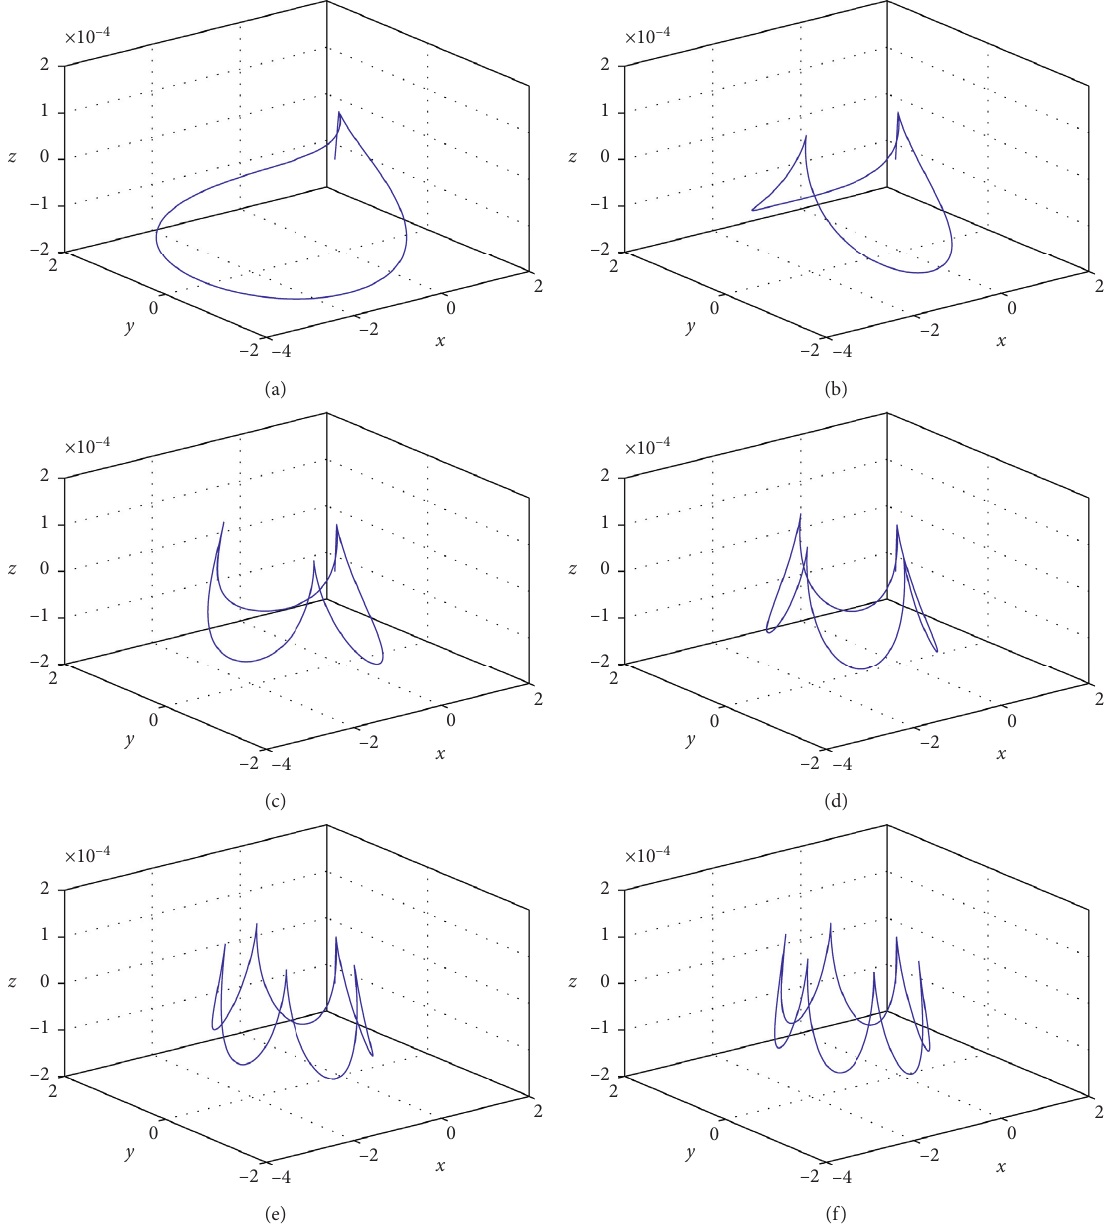
Figure 3: Periodic orbits when e � 0 . 1 ,f 0 � π /3, and velocity _ y 0 � 0 . 002. (a) Single-loop orbit, when x 0 � 0.093525298500. (b) Two-loop orbit, when x 0 � 0.059057635000. (c) Three-loop orbit, when x 0 � 0.043092145000. (d) Four-loop orbit, when x 0 � 0.033847995000. (e) Five- loop orbit, when x 0 � 0.027812858705. (f) Six-loop orbit, when x 0 �